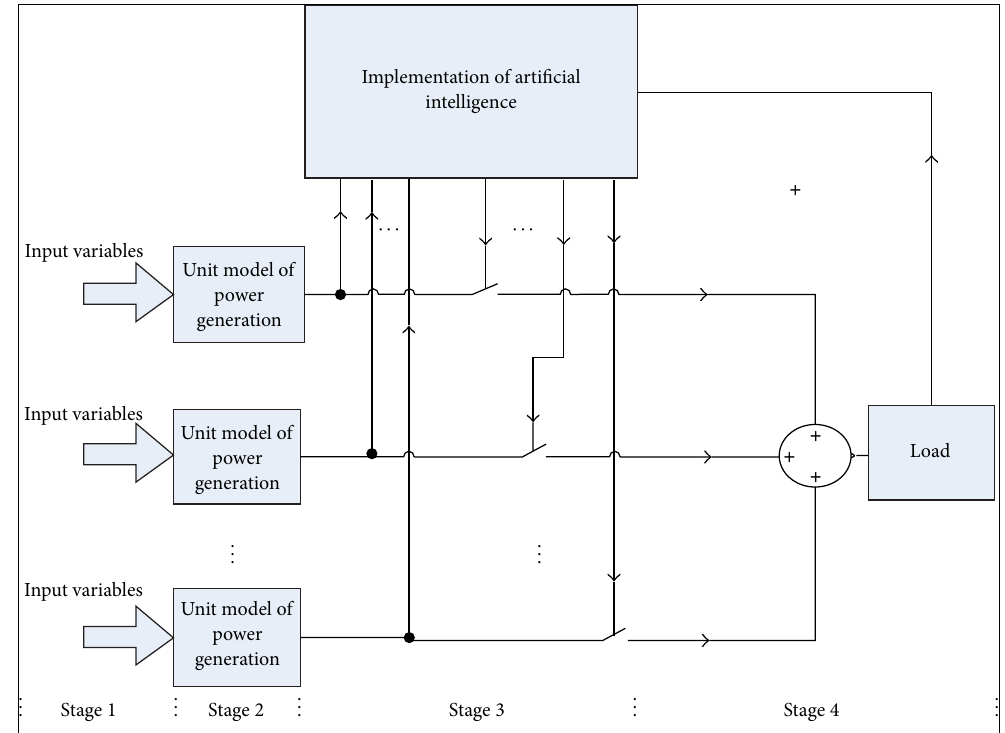
Figure 1: Proposed framework for the hybrid energy switching